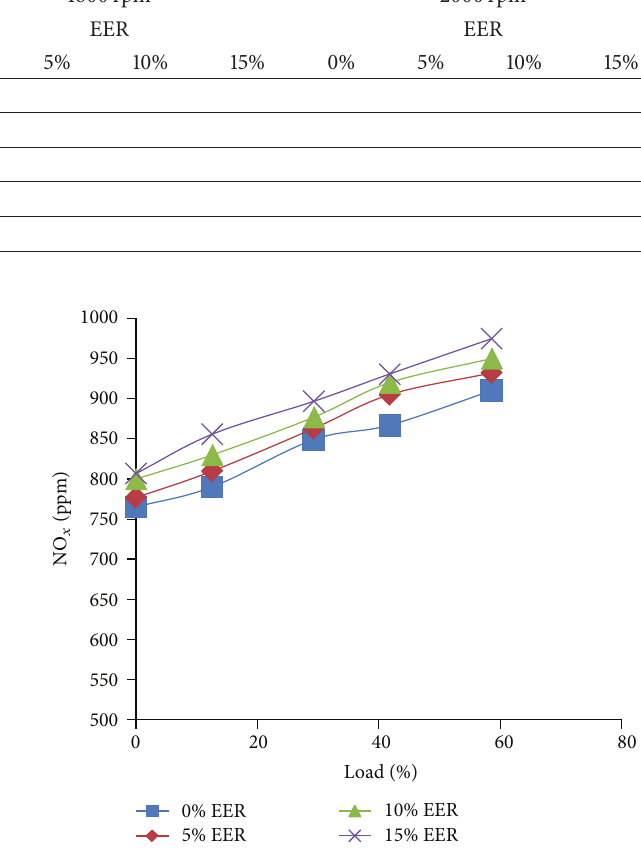
Figure 5: Effect of load on NO